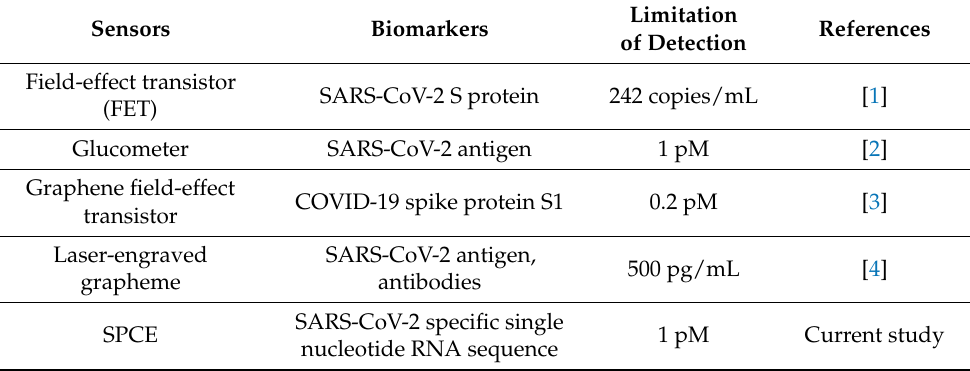
Table 1. Comparison of our current study results and other similar SARS-CoV-2 detectors.